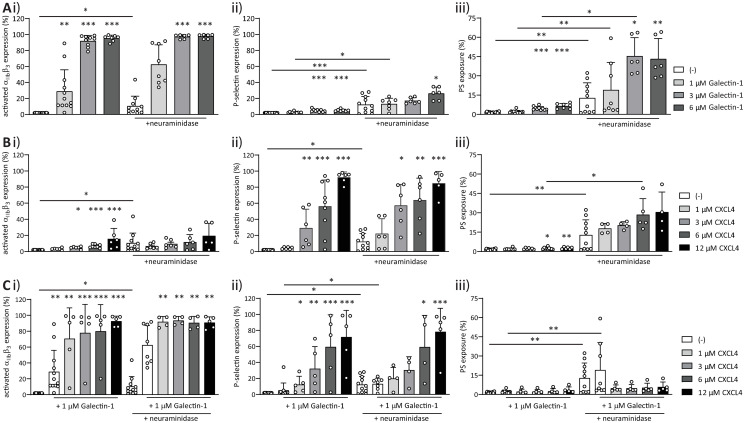
Neuraminidase-treatment causes more inside-out signaling by galectin-1, unaltered CXCL4 response and a higher PS-exposure independent of either gal-1 or CXCL4.Platelets were incubated for 60 min at 37°C without or in the presence of neuraminidase (200 mU per 109 platelets). Flow cytometry measurement of integrin αIIbβ3 (i), P-selectin (ii) and PS-exposure (iii) of platelets treated with 1, 3, or 6 μM gal-1 (A), 1, 3, 6, or 12 μM CXCL4 (B), or different concentrations of CXCL4 incubated with 3 μM gal-1 (C). Bars represent mean ± SD (n ≥ 3), *p < 0.05, **p < 0.01, ***p < 0.001 as compared to vehicle within appropriate treatment with or without neuraminidase or conditions compared between treatments (Kruskal Wallis/Dunn’s test).